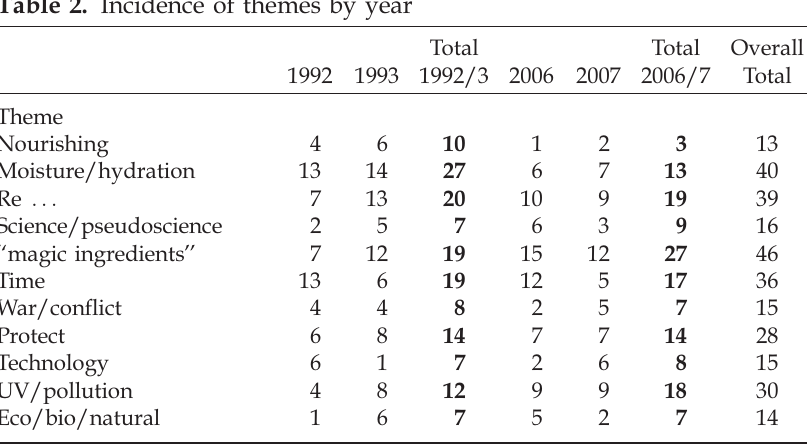
Table 2. Incidence of themes by year